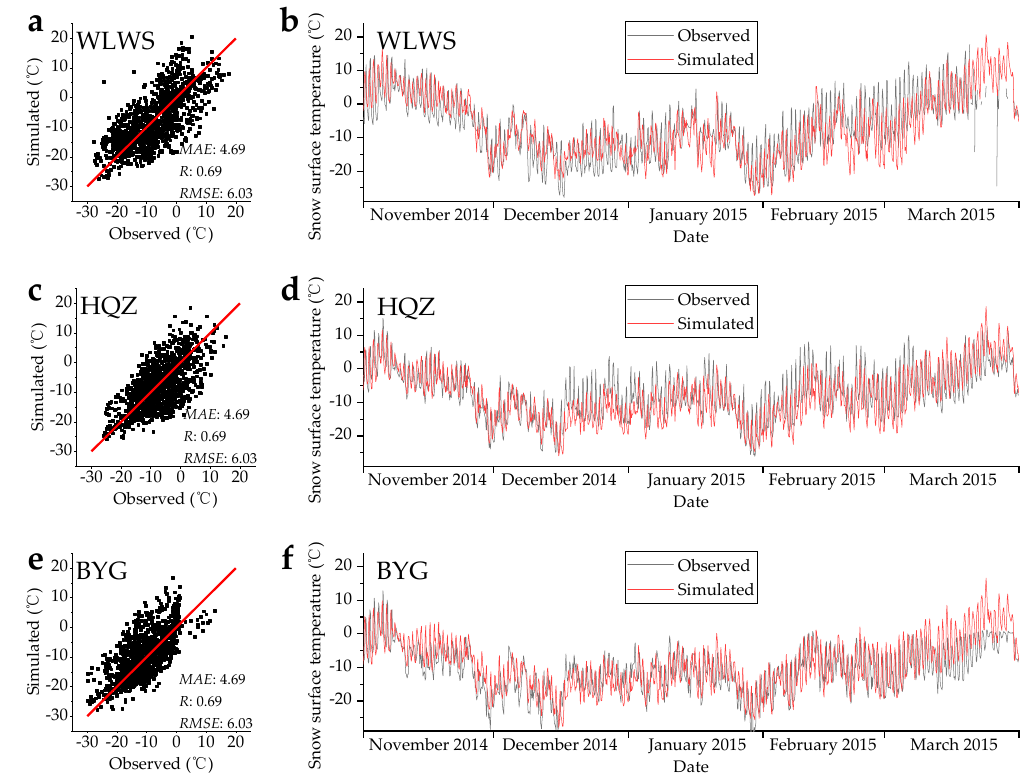
Figure 4. The scatter diagrams and time series data of the measured (three automatic snow variable measurement systems) and simulated 3-hour average snow surface temperatures between 0:00 on 1